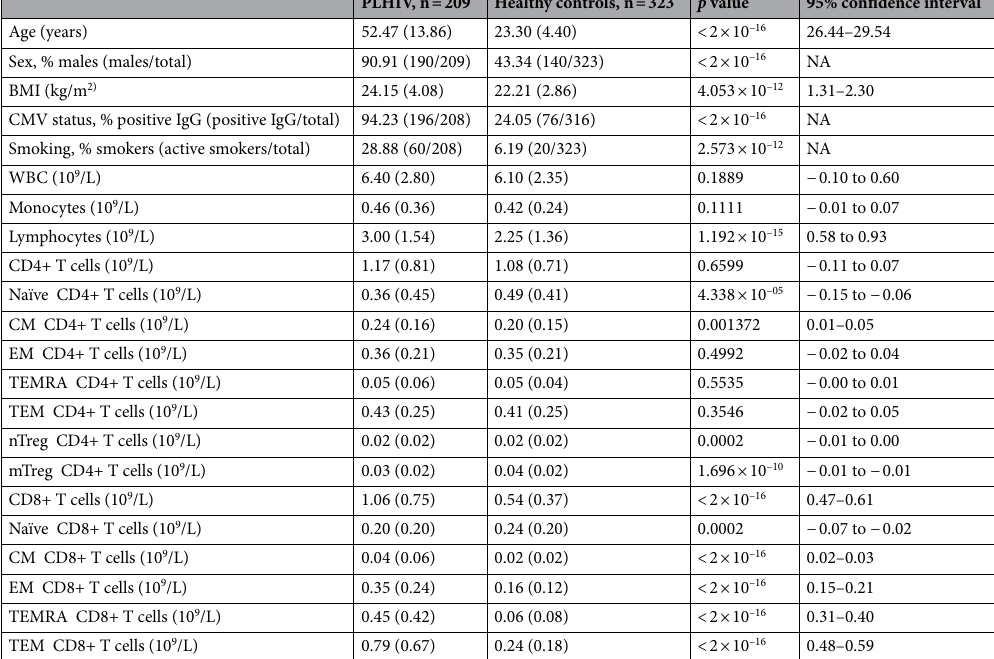
Table 1. Baseline characteristics in PLHIV and controls. To test for significant differences between the two groups, Mann–Whitney U test was used for continuous variables and chi-square test for binominal categorical variables. Data were summarized as medians and IQR. PLHIV = people living with HIV, BMI = body mass index, CMV = cytomegalovirus, WBC = white blood cell count, CM T cells = central memory T cells, EM T cells = effector memory T cells, TEMRA cells = T effector memory cells expressing CD45RA, nTreg = naïve regulatory T cells, mTreg = memory regulatory T cells. Differences in cell counts of nTreg CD4+ T cells,